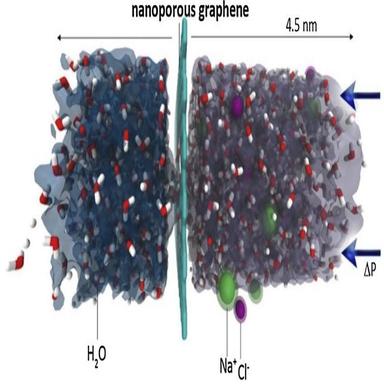
Sideview of the computational system studied by Choen-Tanugi and Grossman .